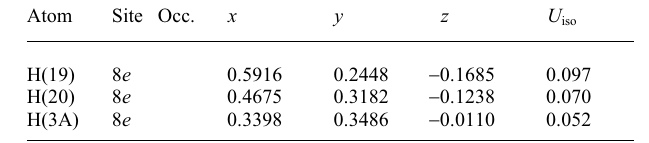
Table 3. Atomic coordinates and displacement parameters (in Å 2